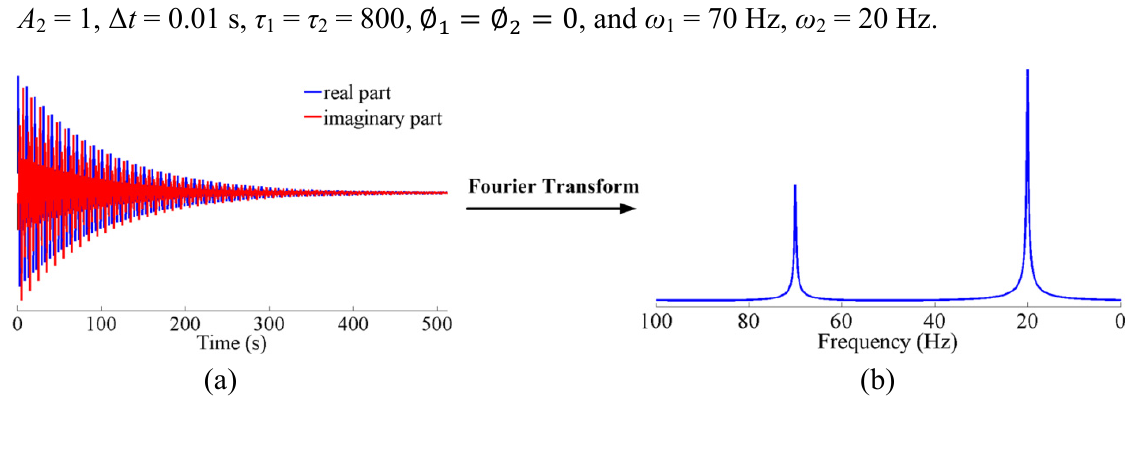
Figure 1. Simulated FID data in time domain ( a ) and its corresponding 1D NMR spectrum ( b ). Note: the FID is simulated according to Equation (1) with J = 2, A